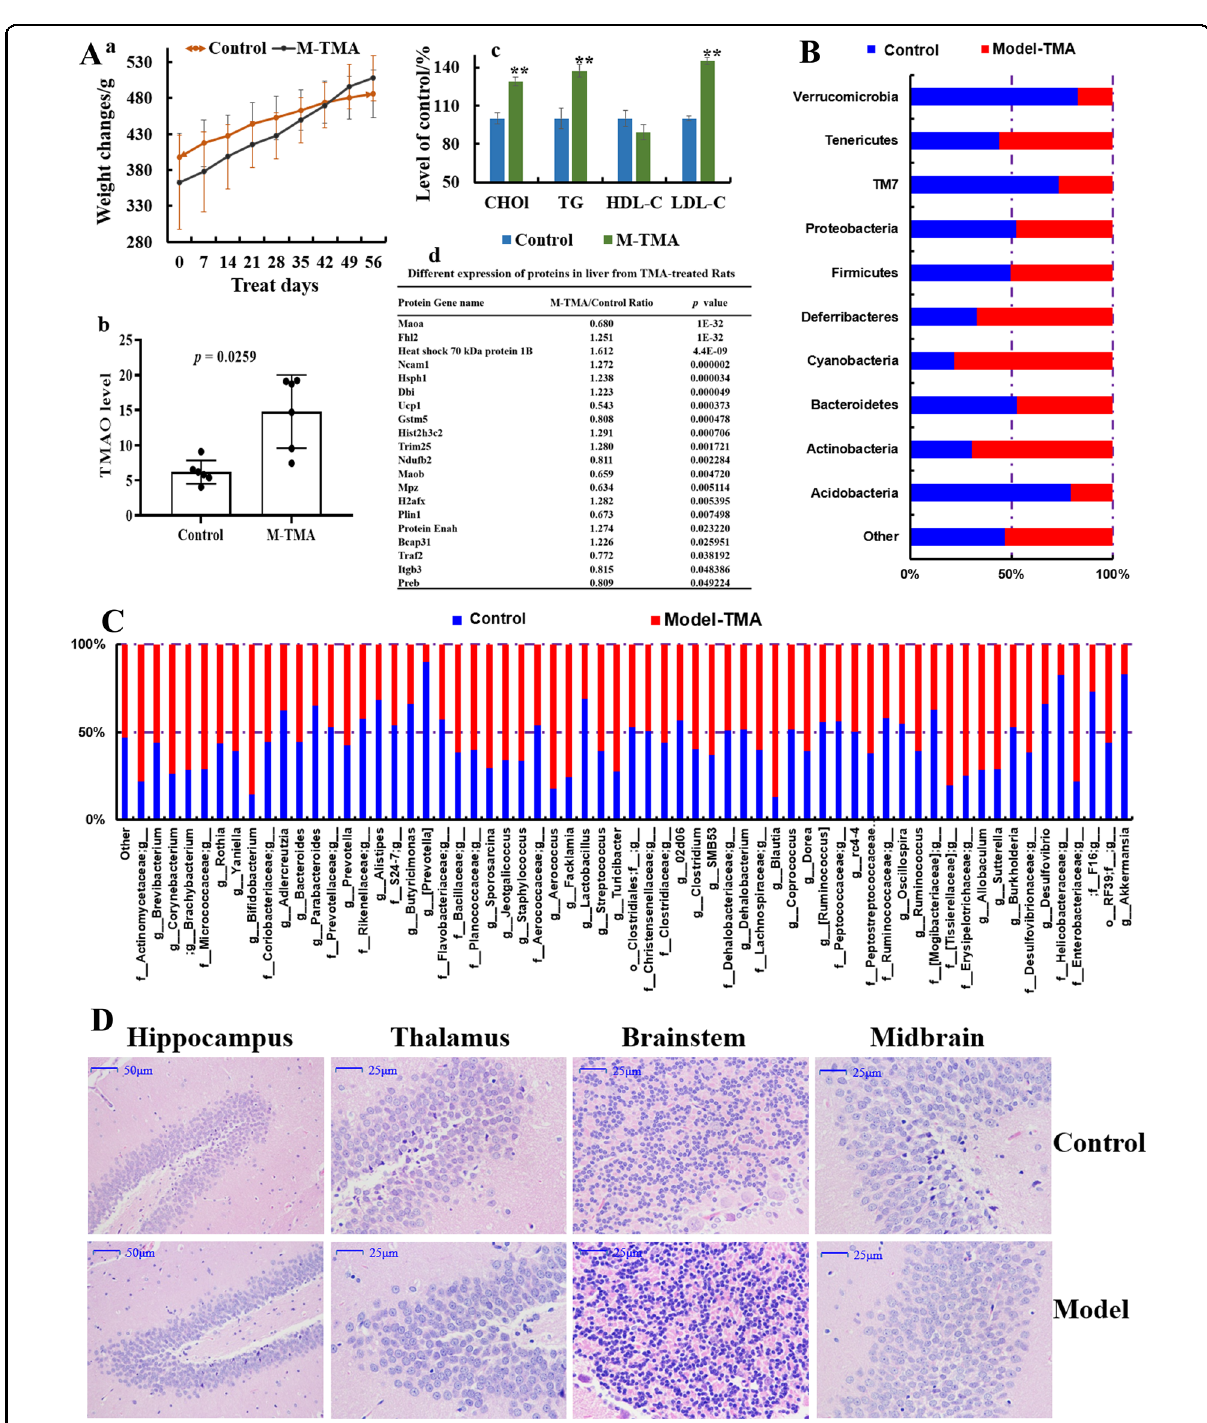
Fig. 8 Effects of trimethylamine (TMA) on rats. A Effects on bodyweight changes (a), levels of T-CHO, LDL, HDL, and TG (b), levels of TMAO (c), and protein expression in liver tissues after intragastric administration of TMA at 0.2 mL/100 g/d of 2.5% for 6 weeks. B Effects on the gut microbiota at the phylum level, and ( C ) at genus level. D Pathologic changes in hippocampus, thalamus, brainstem, and midbrain after TMA administration. Data are the mean or mean ± SD of more than 8 independent experiments. * p < 0.05 and ** p < 0.01 vs. the model group by one-way ANOVA, followed by the Holm – Sidak